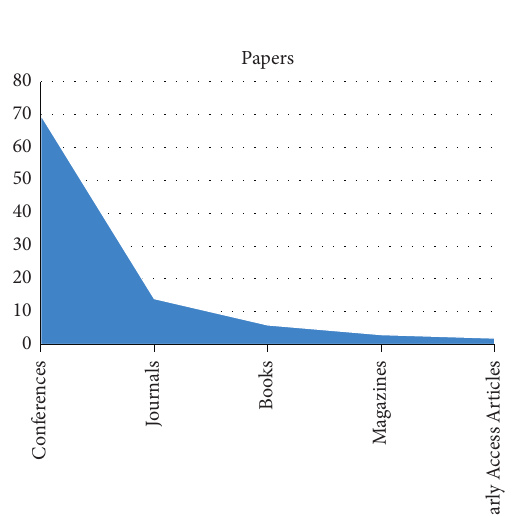
Figure 4: Disciplines of papers.